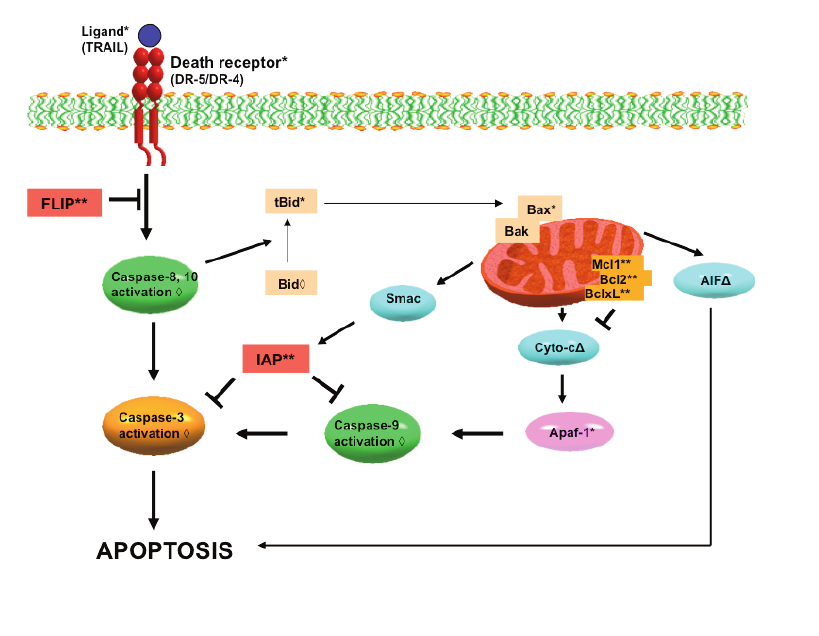
Figure 1. Induction of the extrinsic and intrinsic apoptotic pathway by HDACi in myelo- ma cells. The extrinsic apoptotic pathway is triggered by ligand binding and leads to acti- vation of caspase-8, which, in turn, activates caspase-3. Activation of the intrinsic apop- totic pathway results in the release of three compounds: (a) cytochrome-c (cyto-c) which binds to apoptotic protease activating factor (Apaf-1) to activate caspase-9, (b) apoptosis inducing factors (AIF) and (c) second mitochondria-derived activator of caspase (Smac). FLICE-like inhibitory protein (FLIP) and members to the inhibitors of apoptosis (IAP) are able to prevent apoptosis induced by death receptors or intrinsic pathway respective- ly. Symbols denote compounds that are up-regulated (*), down-regulated (**), activated ( ∏ ) or translocated to cytosol ( r ) by HDACi in myeloma